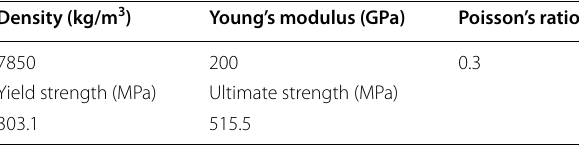
Table 2 Properties of material (34CrMo4)